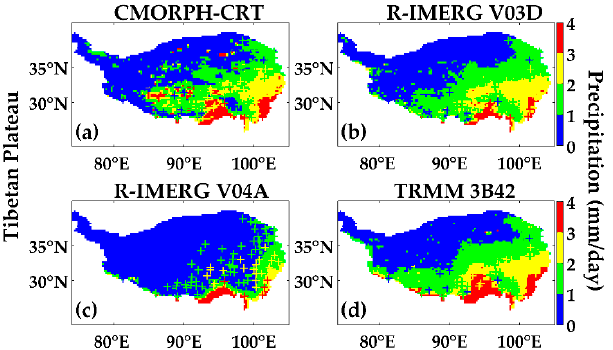
Figure 2. Spatial distribution of mean daily precipitation (mm/day) (sampled between 1 June 2014 and 30 November 2015) at a spatial 0.25° resolution for CMORPH-CRT ( a ); R-IMERG V03D ( b ); R-IMERG V04A ( c ); and TRMM 3B42 ( d ) over the Tibetan Plateau. The pluses represent mean daily precipitation (mm/day) of gauge precipitation estimates (sampled between 1 June 2014 and 30 November 2015).